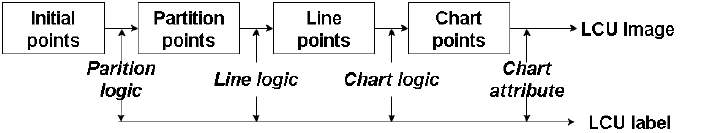
Figure 3. Flow chart of algorithm for data